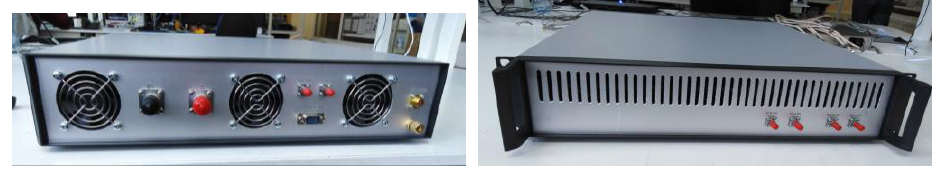
Fig. 4. Appearance of L-band